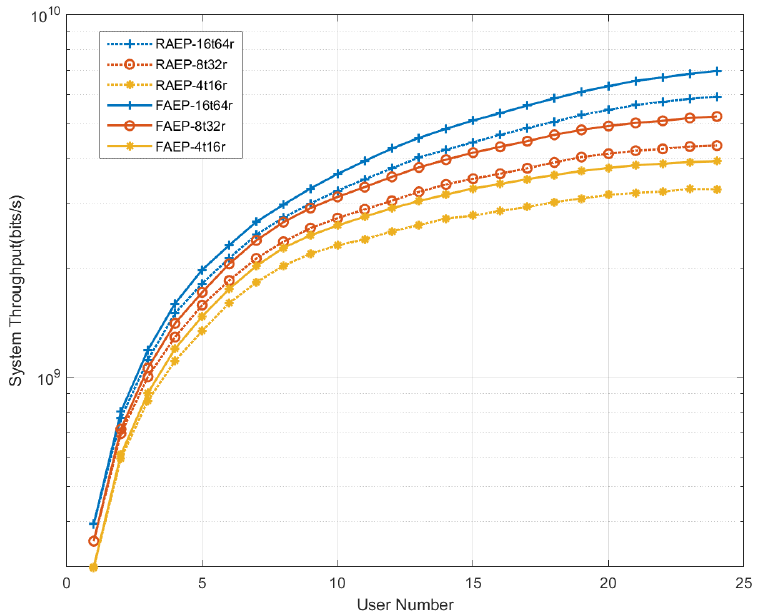
Figure 6. The performance of Algorithm 1 with different number of N t and N r